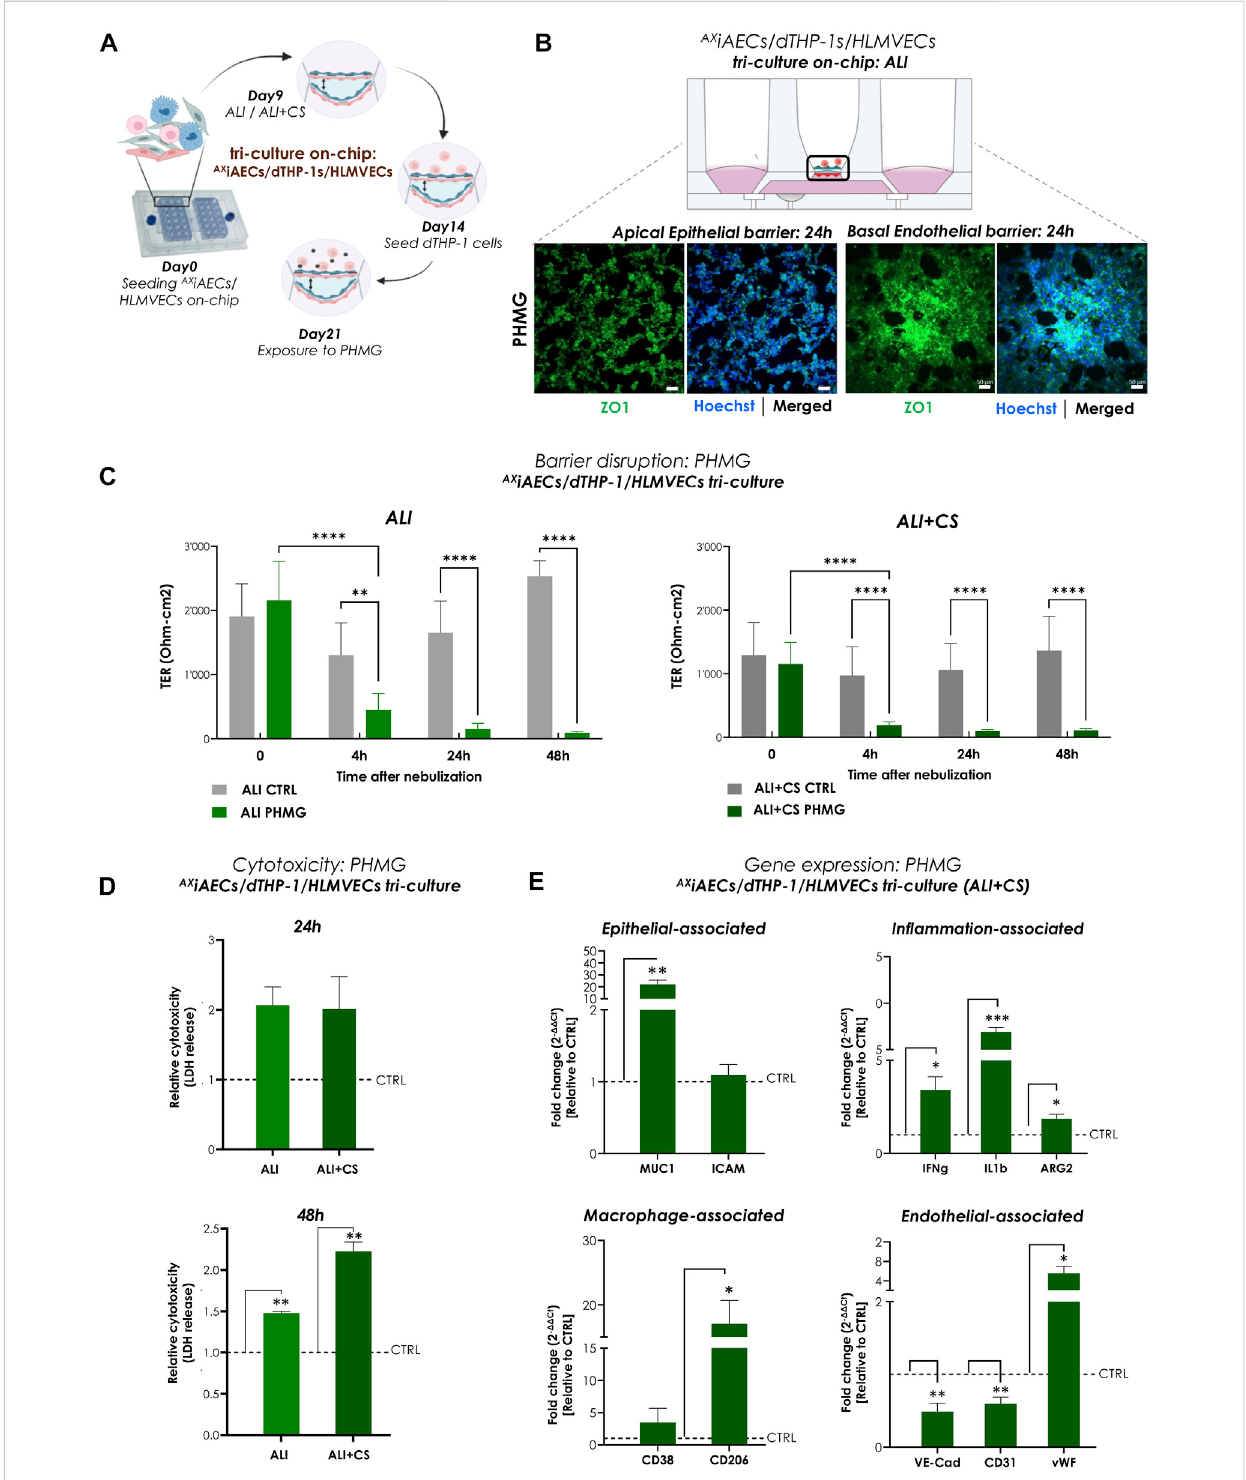
FIGURE 6 AerosolizedPHMGinducedbarrierdisruptionandcytotoxicityintriple-cellcultureon-chip (A) TimelineandschematicofPHMGnebulizationatday 21intri-cellculture( AX iAECs/d-THP1/HLMVEC)modelon-chip. (B) Representativeimmuno fl uorescencestainingforapicalalveolarandbasalendothelial barrierafter24 hofPHMGexposure.Cellswereanalyzedfortightjunction,ZO1(green)andnucleiwithHoechst(blue).Scalebaris50 µm. (C) TERvalues (Ohm-cm 2 )wererecordedbeforePHMGnebulization(at0 h)andat4 h,24 hand48 hafterexposure(N=3;n=12). (D) Cytotoxicitywascalculated fromLDHreleaseat24 hand48 hafterPHMGnebulizationfrombothALIandALI+CSconditions.LDHreleasewasnormalizedwithrespectiveuntreated controls. Data shown as mean ± SEM (N = 1; n = 3/condition/timepoint). (E) Gene expression after 48 h of exposure was assessed for cells in ALI + CS condition. Fold change values were normalized with respective untreated controls. Data presented as mean ± SEM (N = 3; n =